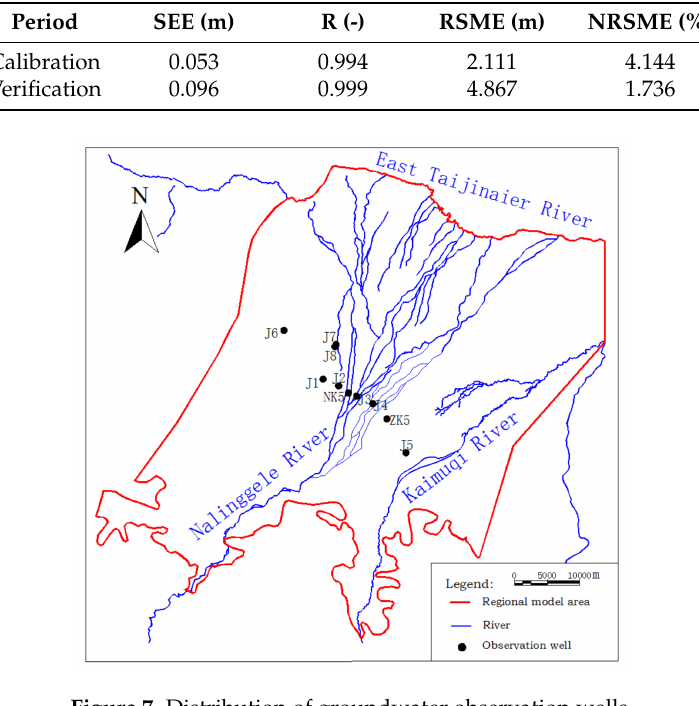
Figure 7. Distribution of groundwater observation wells.